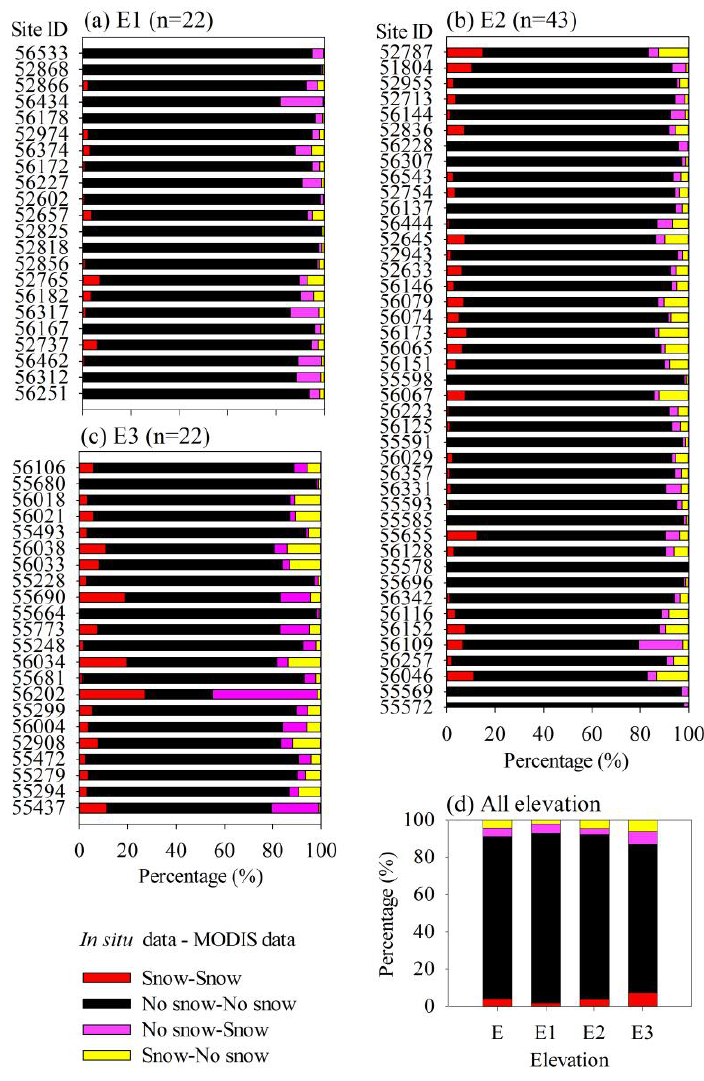
Figure 3. Overall performance of snow classification accuracy at 87 stations from 2000 to 2011 among different elevations (E1: ≤ 3000 m ( a ), E2: 3000–4000 m ( b ); E3: >4000 m ( c ); E: all sites ( d )).